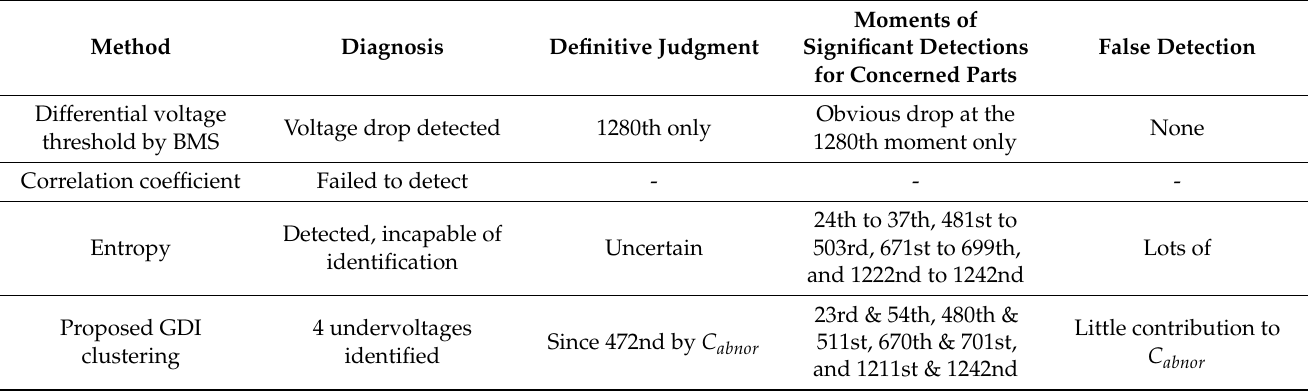
Table 3. Performance of the Methods in Case